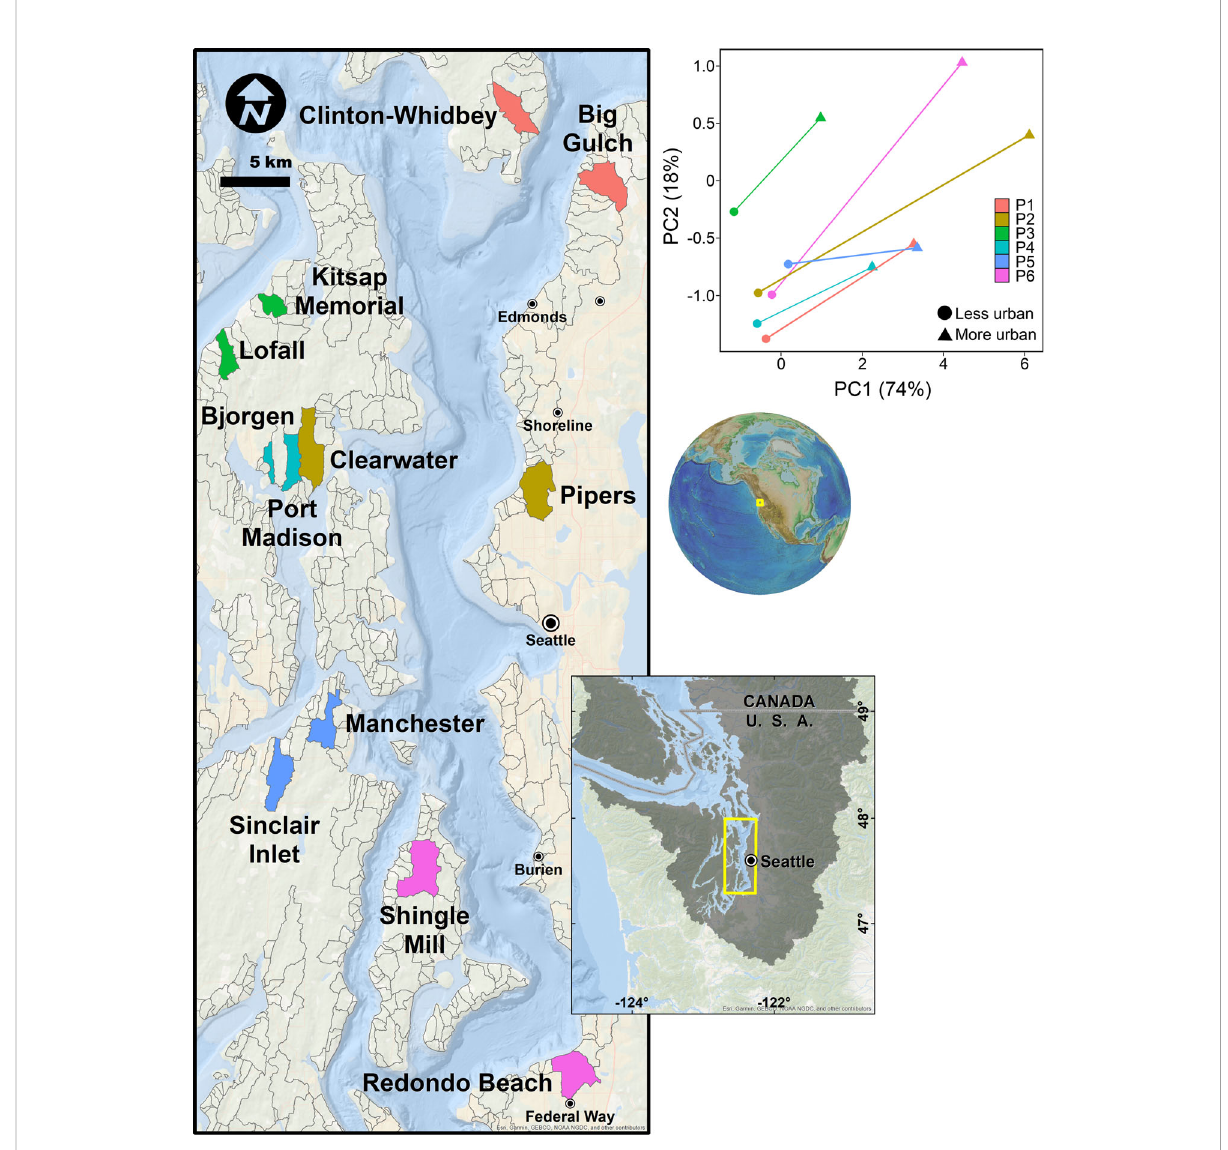
FIGURE 1 Map of watersheds used for this study (colored polygons), contextualized relative to other candidate watersheds considered (gray outlines), along with a principal components analysis of watershed pairs used to de fi ne the urban gradient. Larger values of PC1 and PC2 indicate increasing